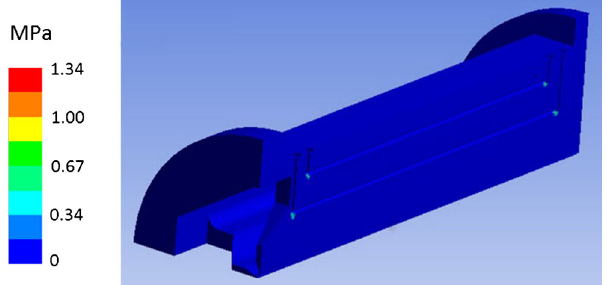
FIG. 13. von Mises stress distribution in an unconstrained model.